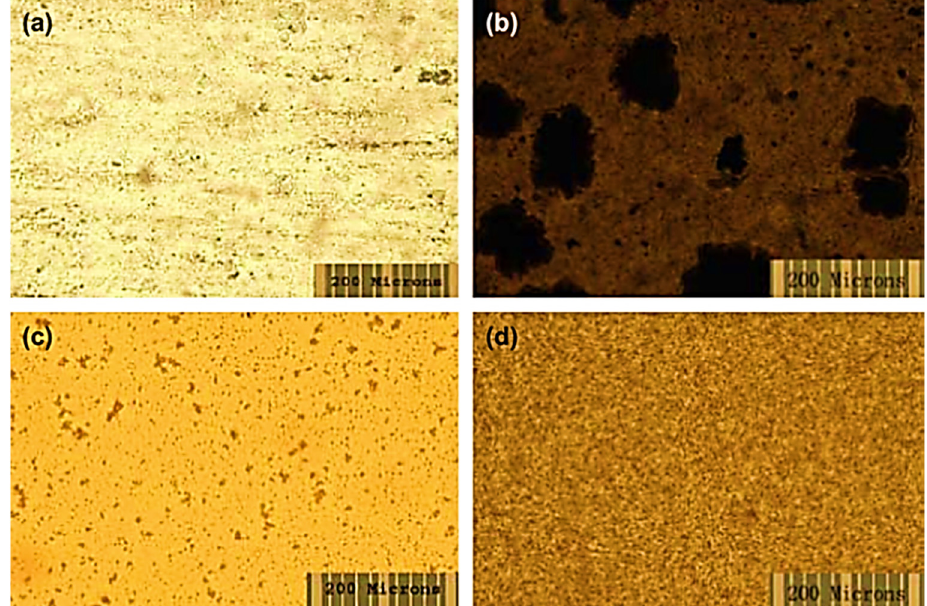
Figure 5. Optical micrographs of Nafion/C 60 fullerene nanocomposites ( a ) and Nafion/polyhydroxy fullerene nanocomposites ( b ) by doping and Nafion/C 60 fullerene nanocomposites ( c ) and Nafion/polyhydroxy fullerene nanocomposites ( d ) by solution casting [176]. Reproduced with permission from Elsevier.